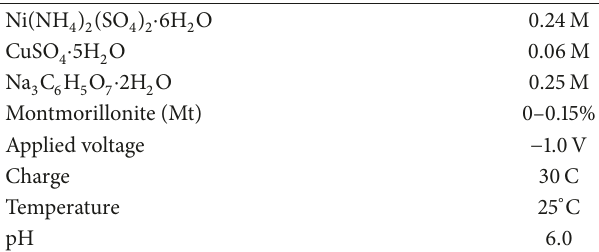
Table 1: Deposition conditions for the Cu-Ni-Mt composite coat-